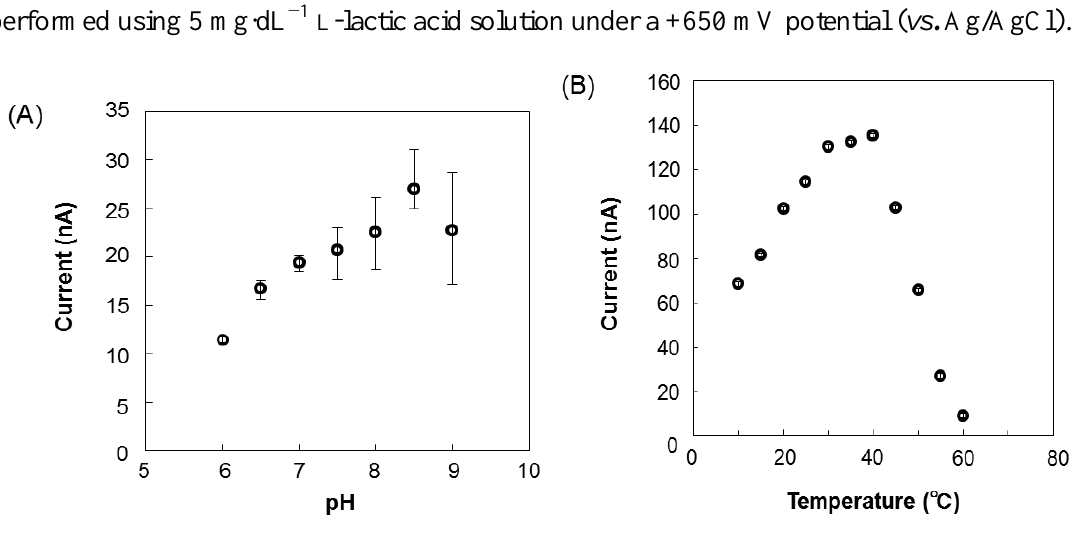
Figure 6. Typical effects of pH ( A ) and temperature ( B ) on the L -lactic acid sensor response. In (A) the temperature was 30 °C, in (B) the pH was 8.0. The measurements